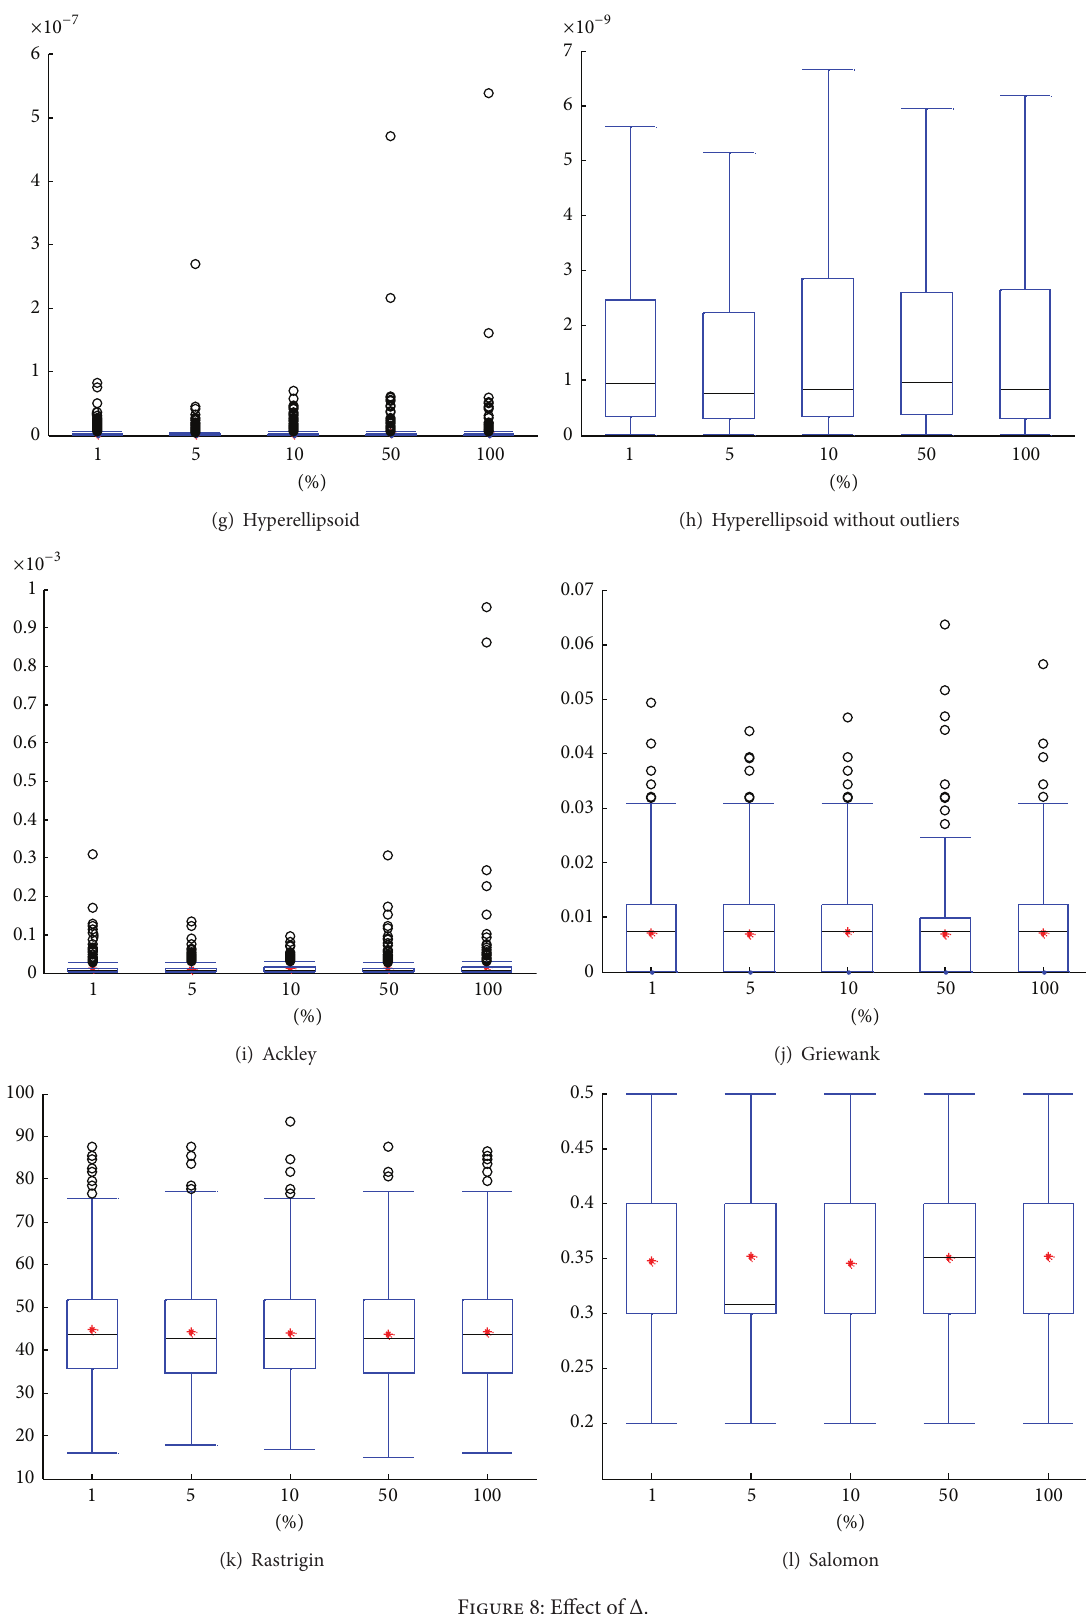
Figure 8: Effect of Δ